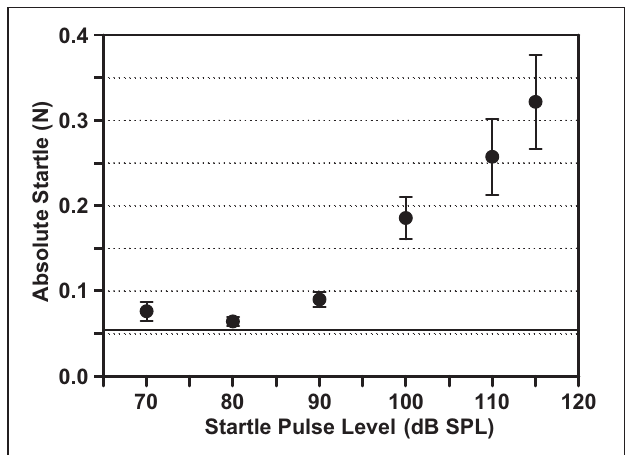
FIGURE 4 | Acoustic startle response amplitude varies with the startle stimulus level and does not saturate up to 115dB SPL. The startle amplitudes are plotted in response to different intensity pulses embedded in a background noise band of 12–14kHz/70dB SPL. Mean ± SEM for eight animals are shown, including two test days per animal. The horizontal line marks the Mean + SEM of the animal’s background movement (without sound